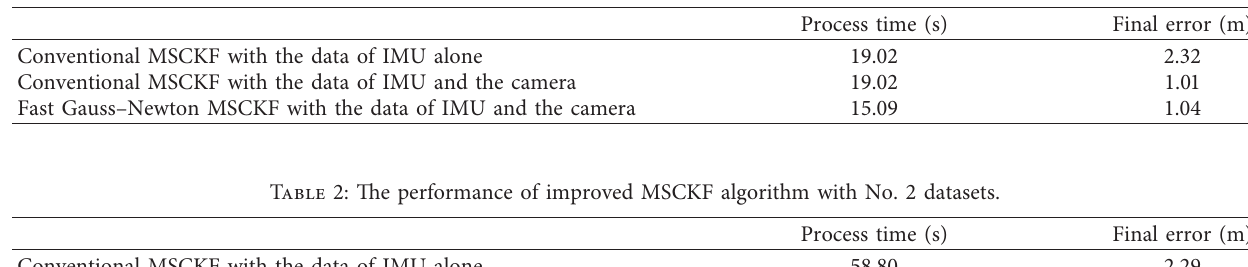
Table 1: The performance of the novel MSCKF algorithm with No.1 datasets.